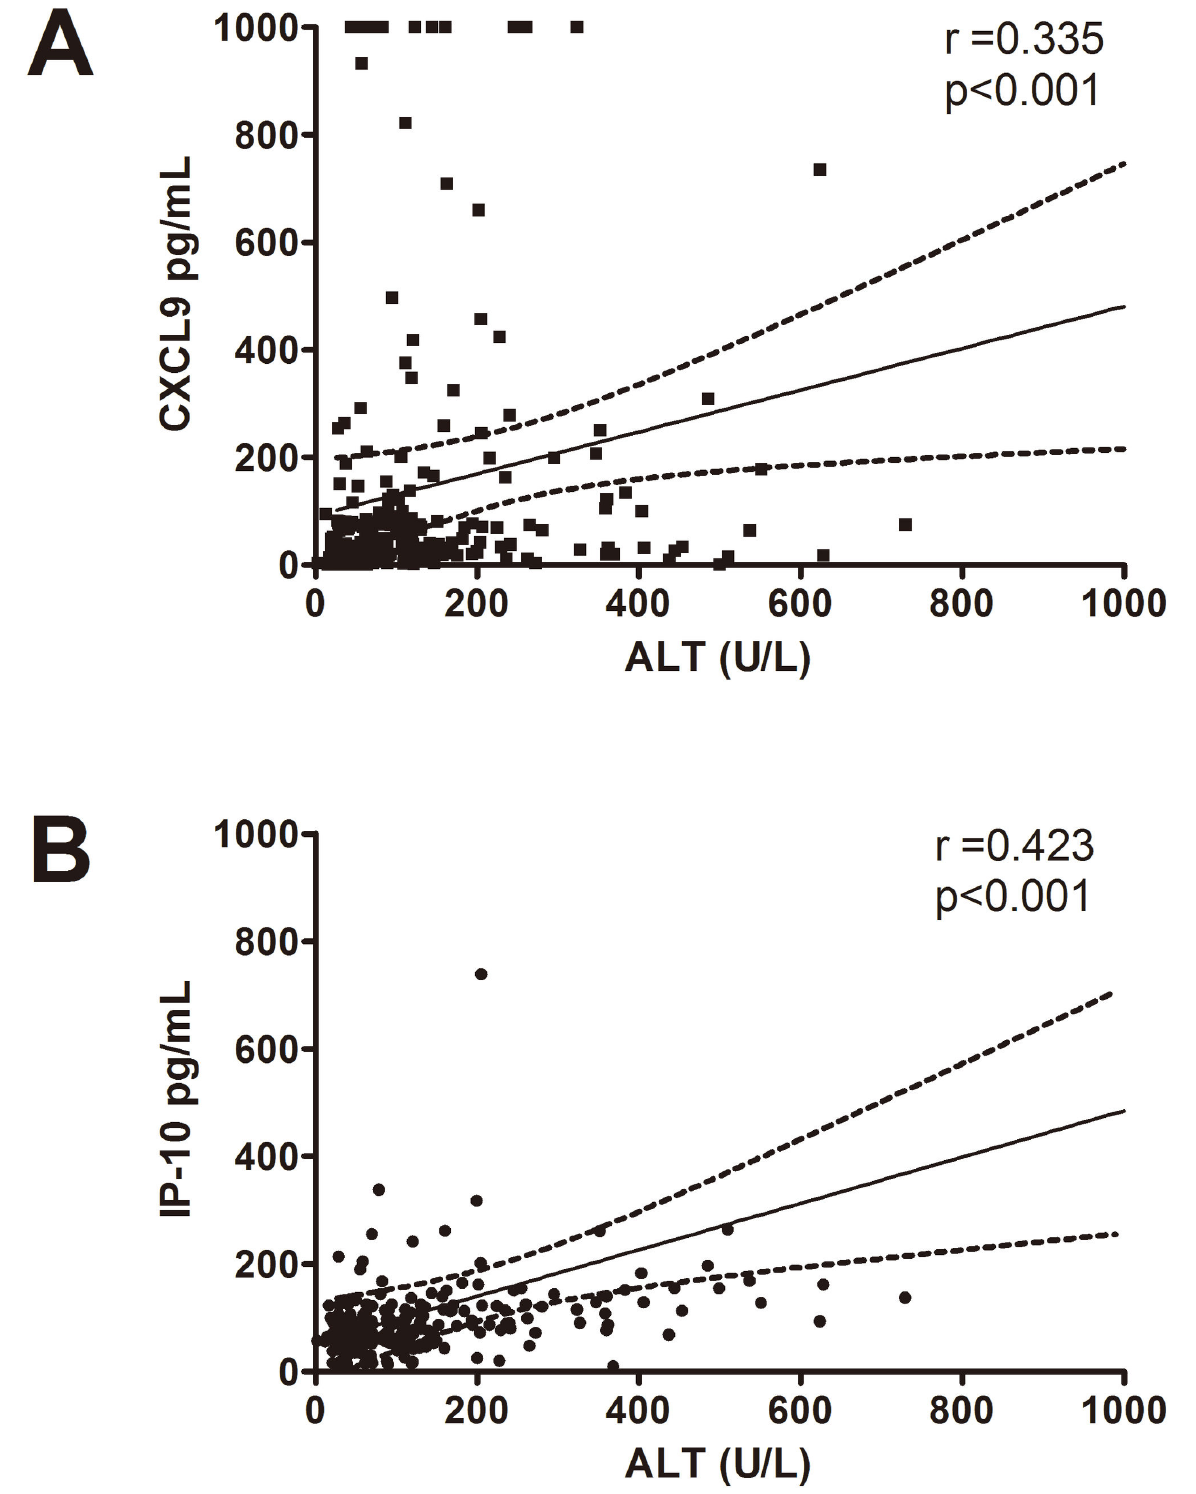
Figure 2. Correlations between serum ALT and chemokine levels. (A) A positive correlation between CXCL9 and ALT; (B). A positive correlation between IP-10 and ALT. Concentrations of serum ALT, CXCL9 and IP-10 levels were collected at each time point during PEG-IFN treatment (overall n=232). doi: 10.1371/journal.pone.0076798.g002 PLOS ONE |